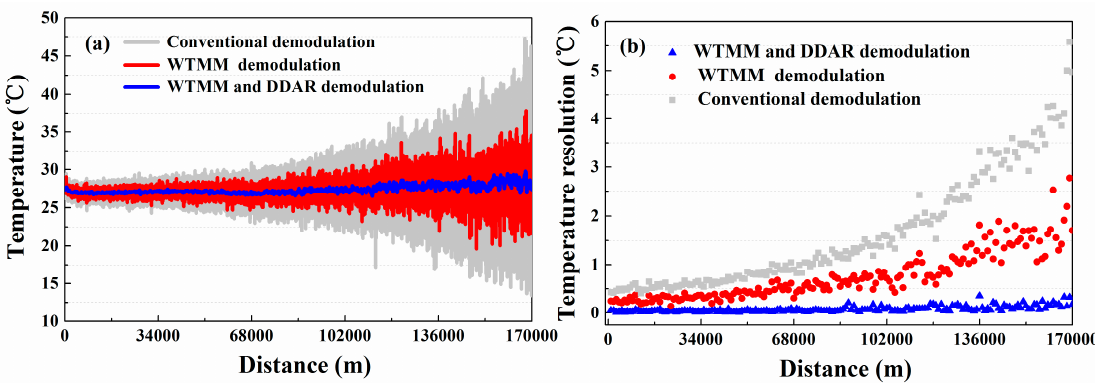
Figure 6. The ( a ) temperature measurement results and ( b ) the temperature resolution using the conventional demodulation, wavelet transform modulus maxima (WTMM), and DDAR demodulation methods for DDP scheme.